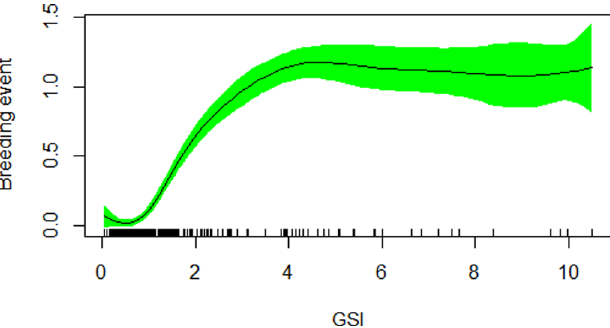
Fig. 6. Pre-spawning fi tness ( K spawn 50 ) of female J. coitor in river Ganga. Dotted lines represent 95%